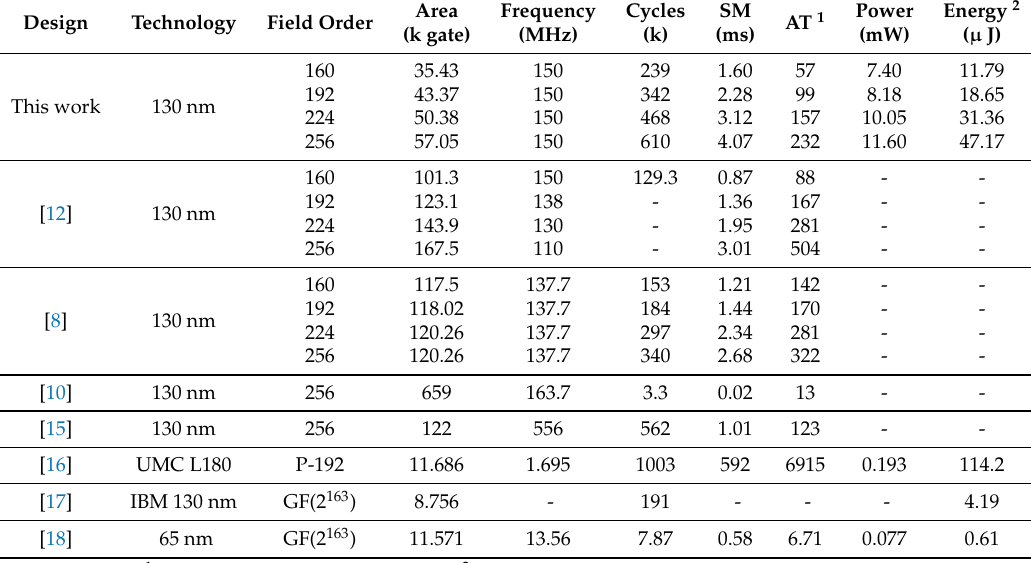
Table 4. ECC Hardware Performance Comparison on